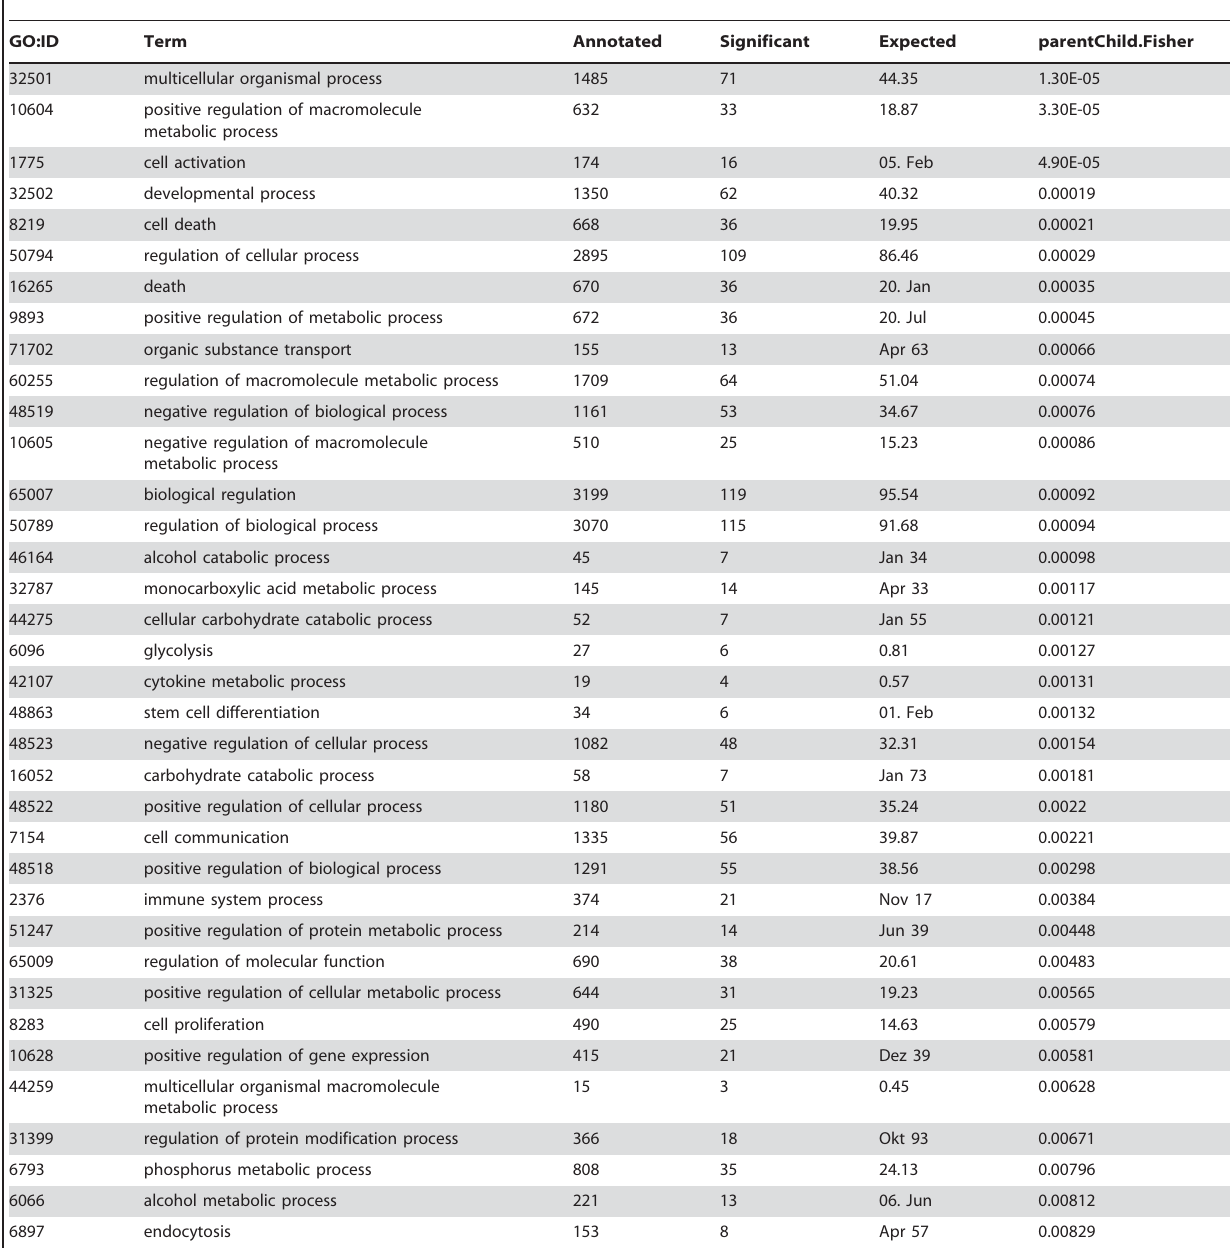
Table 2. Gene Ontology (GO) categories enriched among the genes that are differentially expressed (2-fold) in SCNT and ICSI